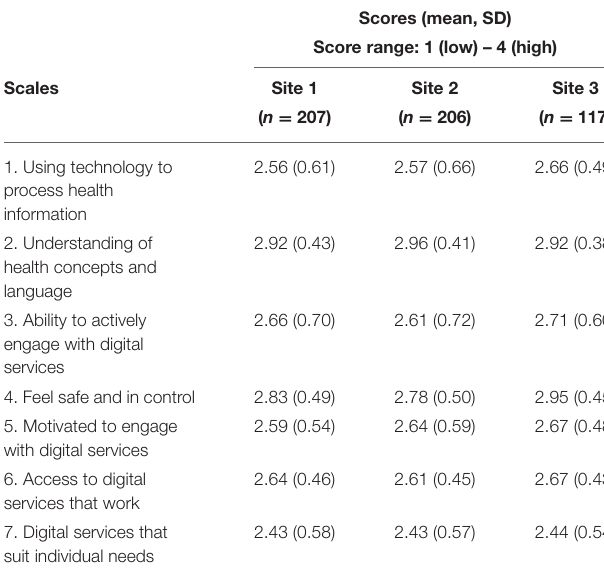
TABLE 3 | eHealth literacy scores of participants of Site 1, Site 2, and Site